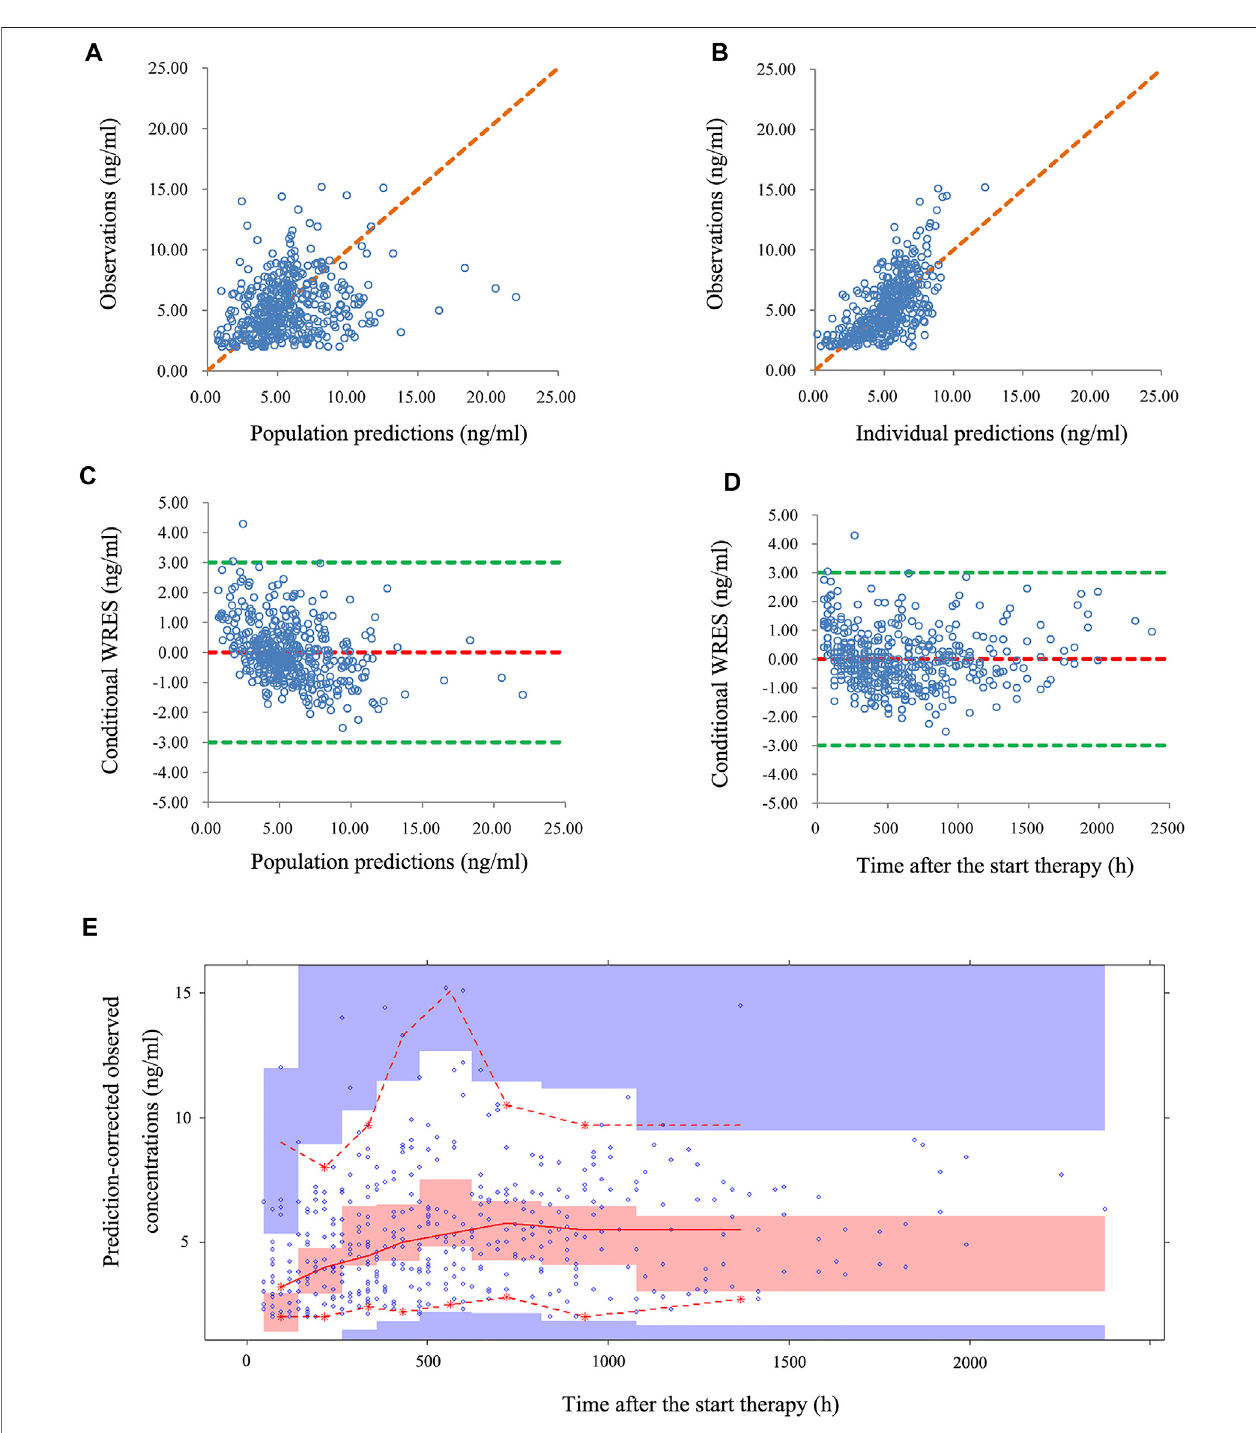
FIGURE1| Modelevaluation. (A) Observations vs. populationpredictions. (B) Observations vs .individualpredictions. (C) Conditionalweightedresiduals(CWRES) vs .populationpredictions. (D) CWRES vs .timeafterthestartoftherapy. (E) Visualpredictivecheck(VPC)ofthemodel.Themiddlesolidlinerepresentsthemedianofthe prediction-corrected concentrations. The lower and upper dashed lines are the 2.5th and 97.5th percentiles of the prediction-corrected concentrations, respectively.